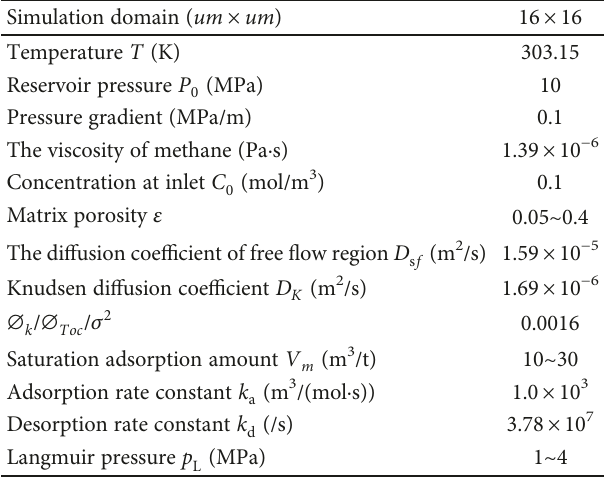
Table 1: Input parameters in